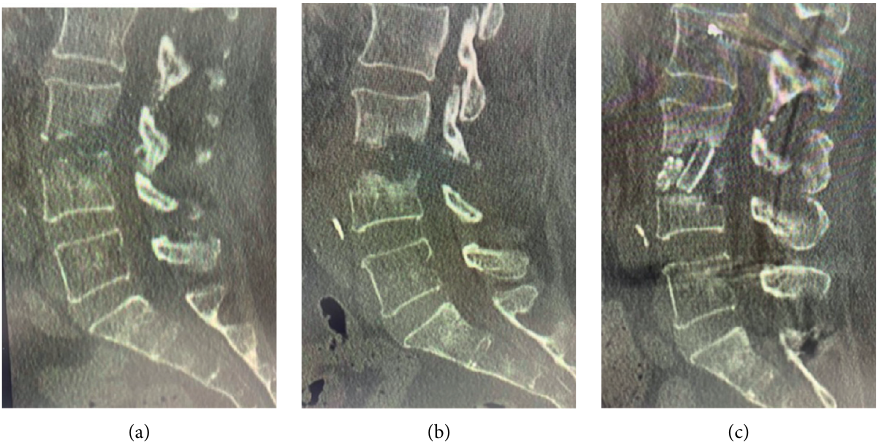
Figure 1: A 70-year-old female was diagnosed with L3/L4 infectious spondylitis and underwent endoscopic debridement, although the pain was increased postoperatively. She underwent anterior reconstruction surgery with iliac autograft. (a) The preoperative sagittal CTscan view showing severe osteolytic changes at the L3/L4 level. (b) The post-FED sagittal CTscan view showing an exacerbated defect of the